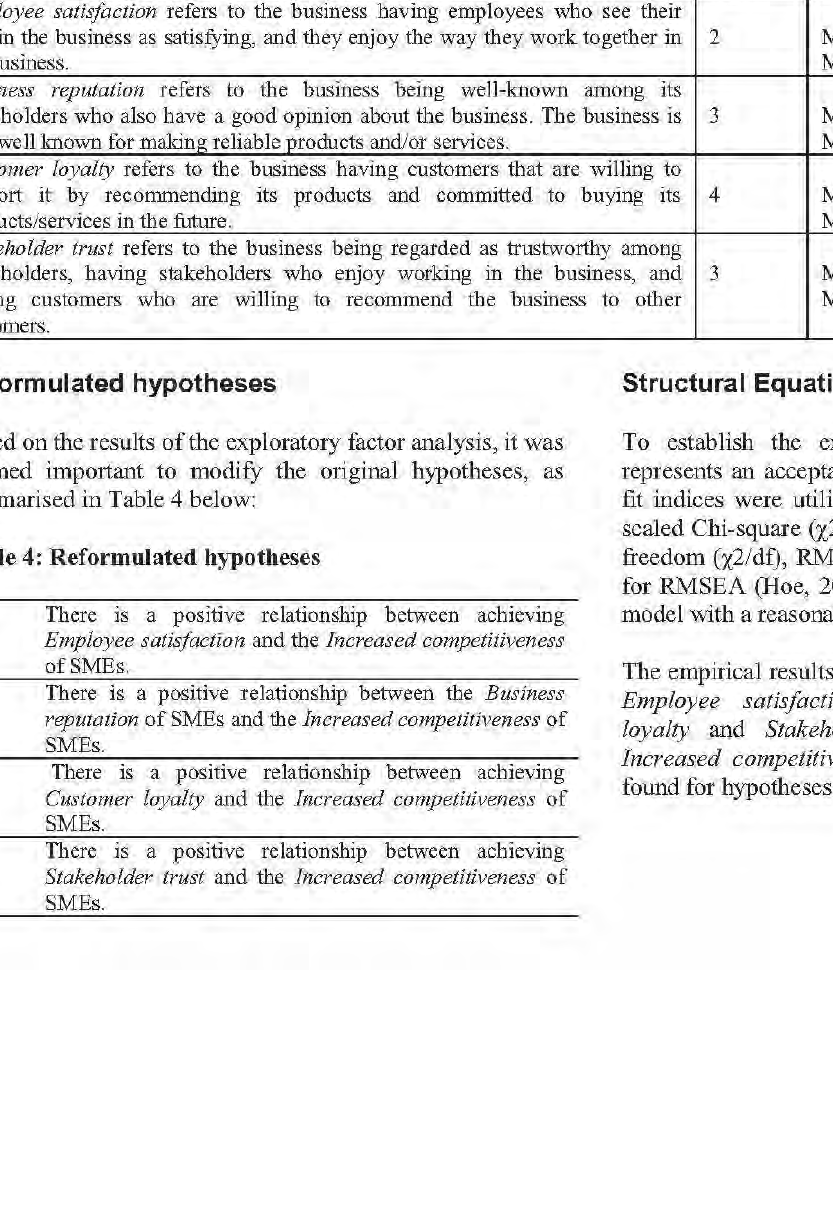
Table 3: Measurement instrument analyses Ope rationalisation of factors